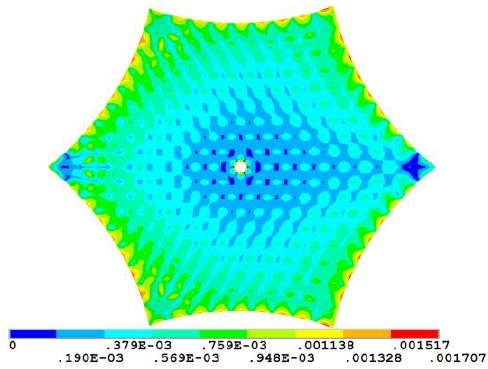
Fig. 8. Mesh node displacement fields, m